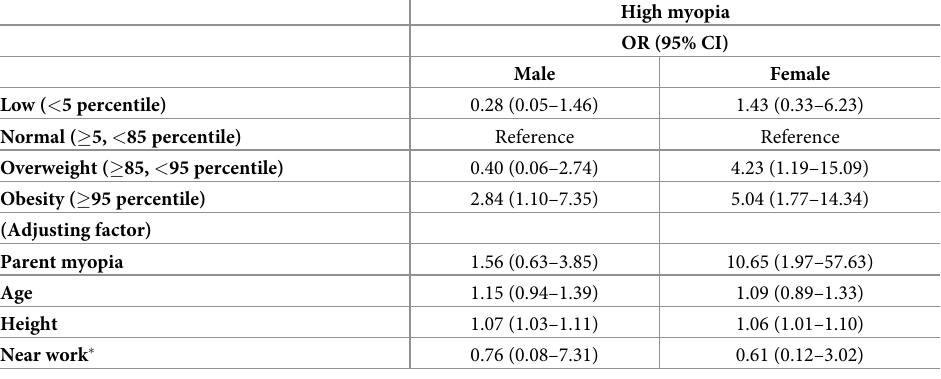
All analyses used integrated weight values. � presented > 1